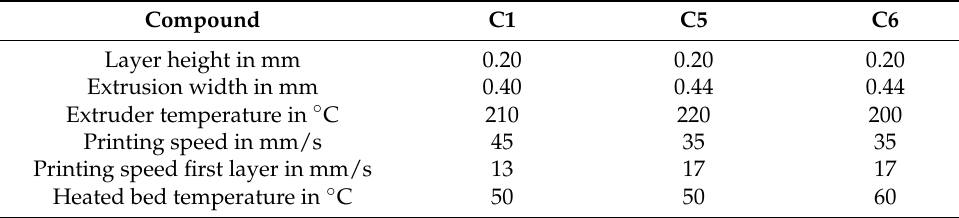
Table 5. Process parameters for